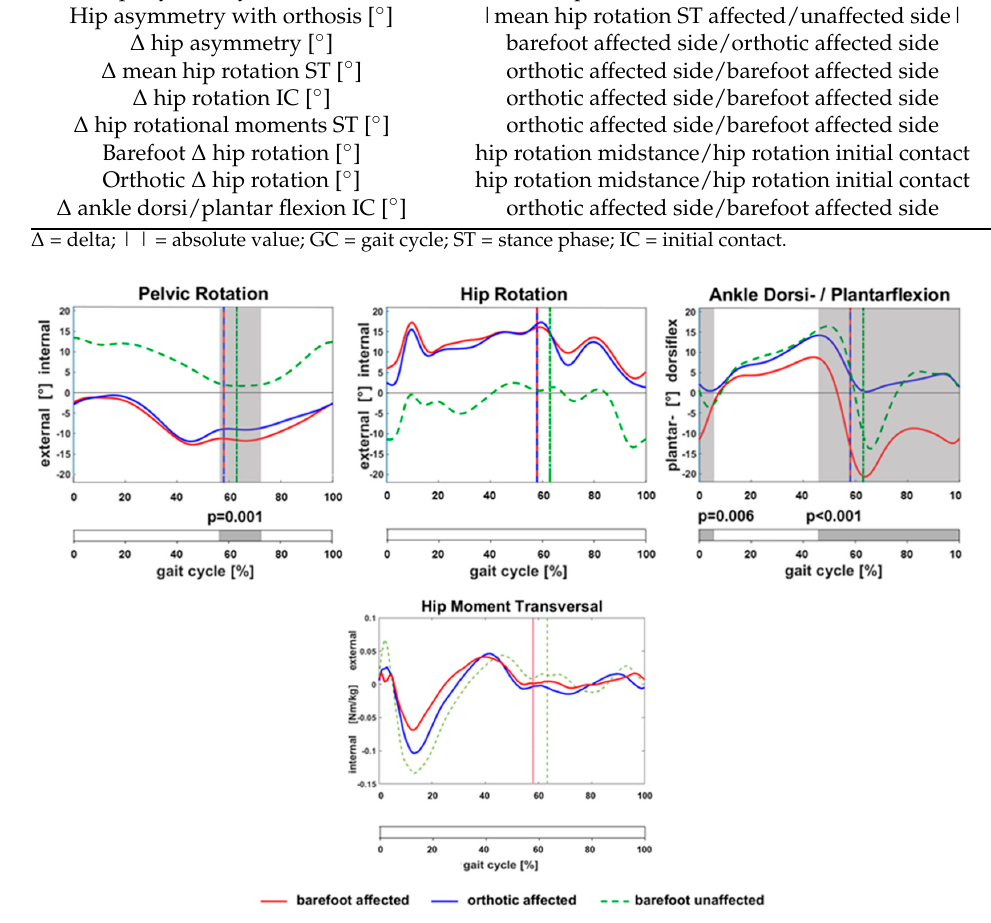
Figure 2. Statistic parametric mapping of kinematics of pelvic rotation, hip rotation, ankle flexion, and hip movement during gait. Grey area: significant changes on affected side between barefoot (red curve) and walking wearing orthoses (blue curve). The kinematics of the unaffected side (green curve) are shown as a reference.